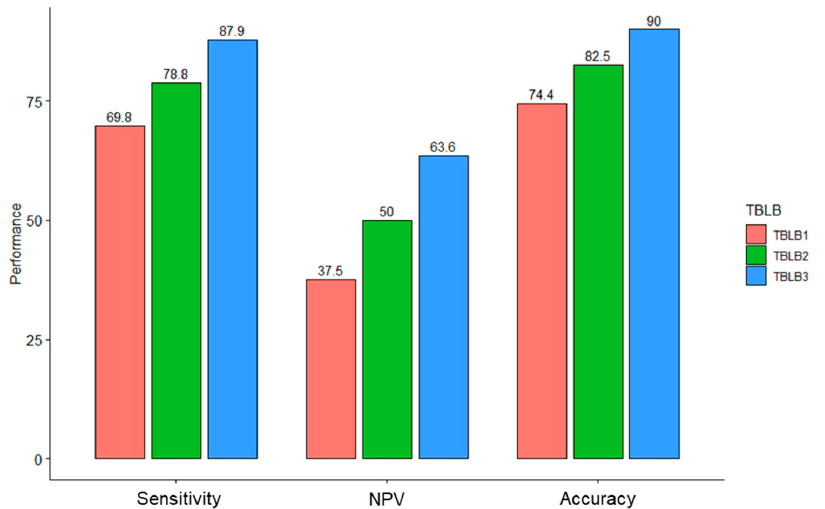
Figure 1. Performance of ENB and R-EBUS-guided TBLB. Diagnostic accuracy was boosted after adding another modality. NPV, negative predictive value; TBLB1, ENB-guided lung biopsy only; TBLB2, ENB-guided lung biopsy plus needle aspiration; TBLB3, ENB-guided lung biopsy and aspiration plus R-EBUS-guided lung biopsy.